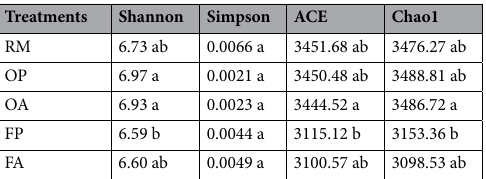
Table 2. Alpha diversity indices of soil bacterial in different rice systems and areas. Different letters within columns indicate significant differences at P < 0.05.